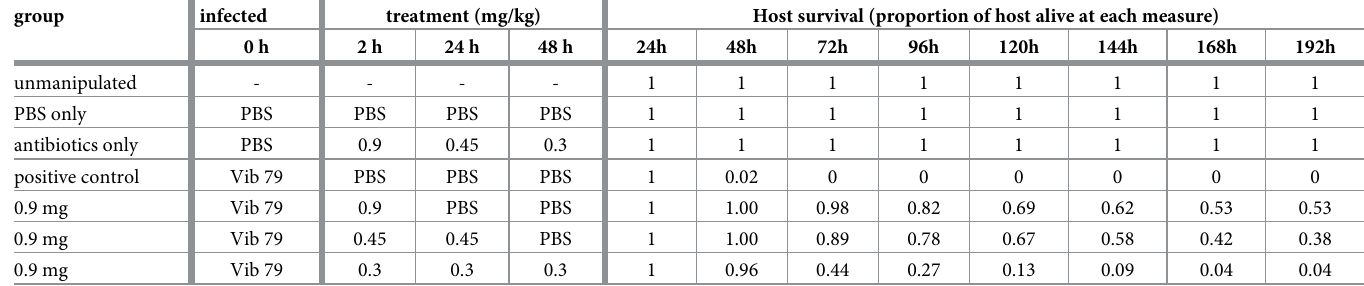
Table 2. Host survival at the end of each 24-h interval for different ‘fixed dose’ treatments, i.e. 0.9 mg either administered as a single dose, or split equally over 2 days, or split equally over 3 days (n = 45). PBS = phosphate-buffered saline; Vib 79 = V . anguillarum (bacterium). group